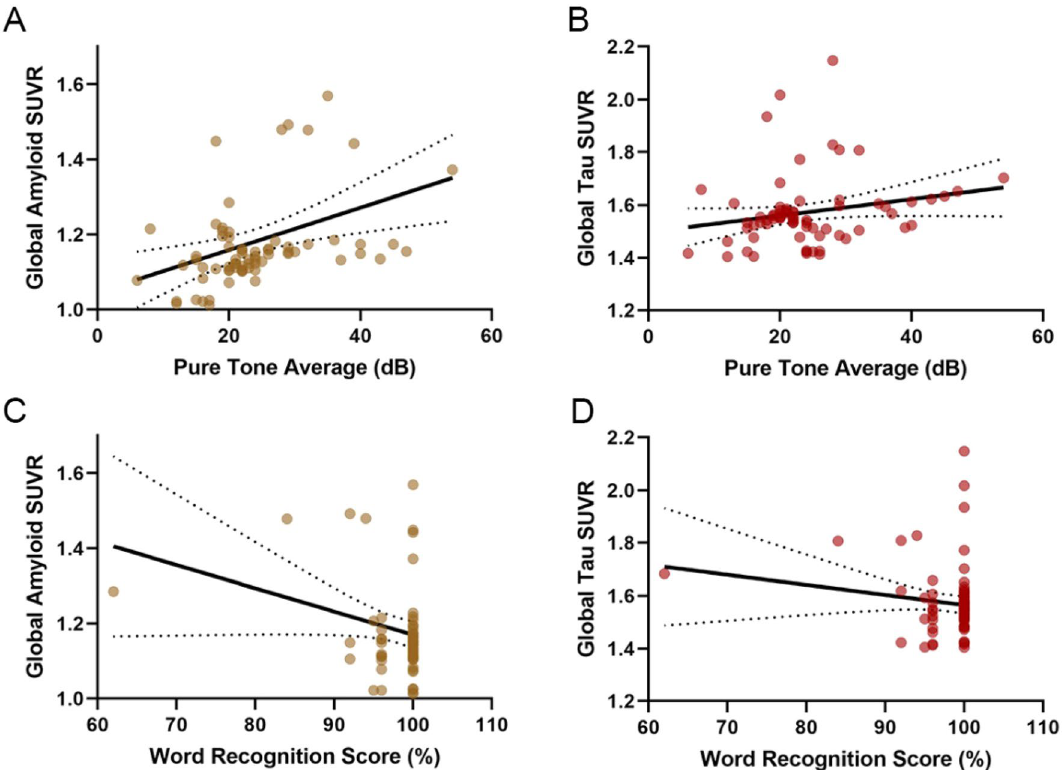
Figure 3. Univariable linear regression models of β-amyloid/tau SUVR based on hearing. ( A ) β-amyloid versus pure-tone average. ( B ) Tau versus pure-tone average. ( C ) β-amyloid versus word recognition score. ( D ) Tau versus word recognition score.